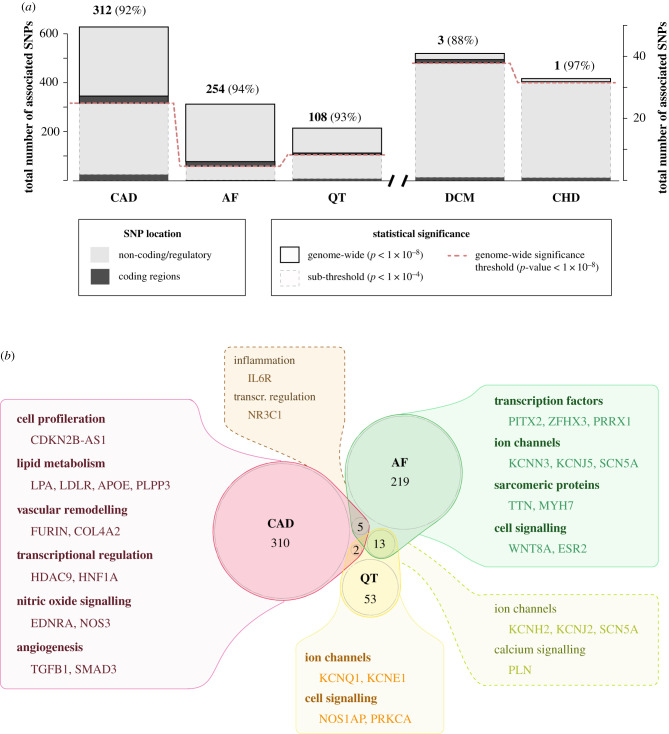
Summary of genome-wide association signals and proximal genes for major cardiovascular diseases and traits. (a) Total number of associated single nucleotide polymorphisms (SNPs) for coronary artery disease (CAD), atrial fibrillation (AF), QT interval duration (QT), idiopathic dilated cardiomyopathy (DCM) and congenital heart disease (CHD). For each disease or trait, top solid-outline boxes correspond to SNPs at genome-wide significance with p-value lower than 1 × 10−8, and bottom dashed-outline boxes to sub-threshold SNPs (p-value < 1 × 10−4). The dashed red line denotes the genome-wide significance threshold. SNPs located in coding regions of the genome are represented as black bars, and with those in non-coding segments in light grey. Numbers on top of each bar indicate the total number of associated SNPs at a genome-wide level of significance (p-value < 1 × 10−8), and percentages the non-coding fraction across all associated SNPs. Data from [5]. (b) Genes proximal to the associated SNPs in (a). (p-value < 1 × 10−8) are represented as a Venn diagram for CAD, AF and QT (centre). Numbers indicate gene counts in each region of the plot, including genes associated with two traits/diseases. The boxes linked to each region summarize example genes proximal to GWAS signals, and the functional categories they belong to.